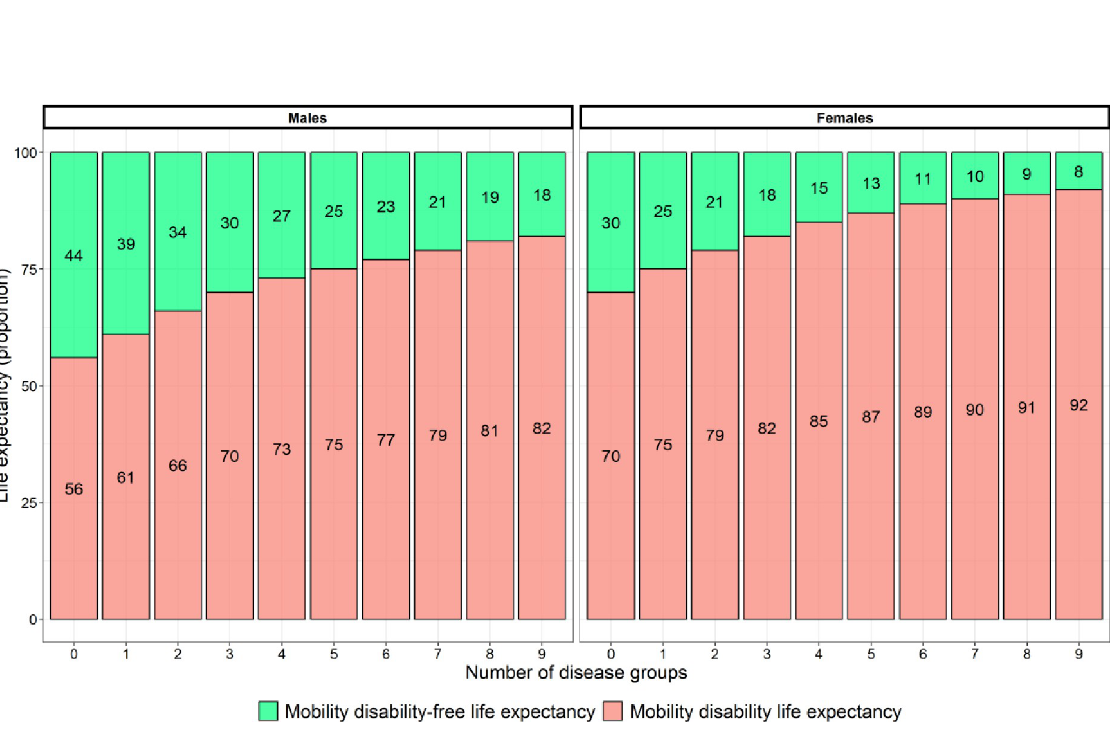
PLOS Medicine| https://doi.org/10.1371/journal.pmed.1004130 November14,